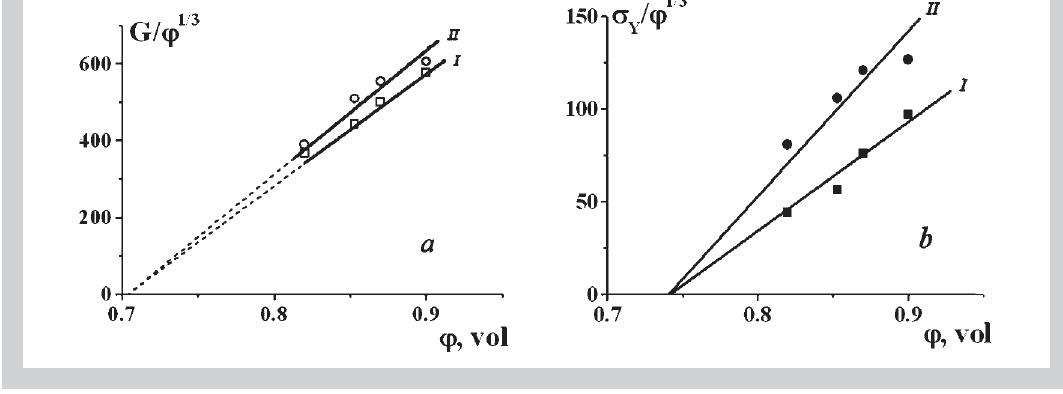
Figure 5: Concentration dependencies of a) elastic modules and b) the yields stress in coordi- nates of the Princen-Kiss theory (I and II – two differ- ent surfactants, D = 16 av